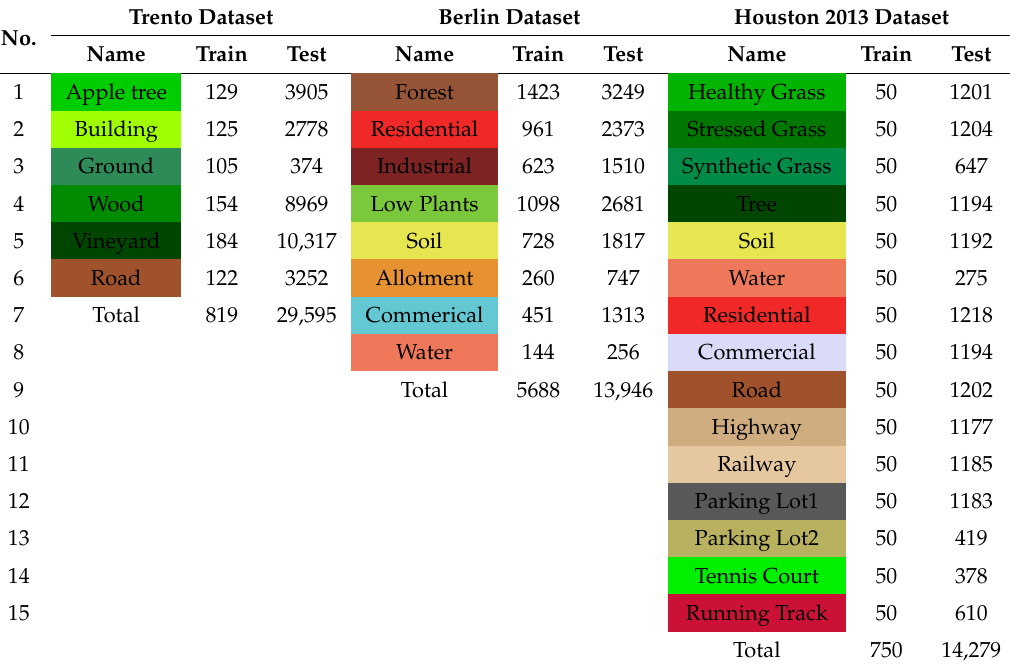
Figure 4. Houston 2013 dataset. ( a ) False color image of HSI (No. 60, 40, and 20). ( b ) LiDAR. ( c ) Groundtruth. ( d ) Class name. Table 1. Number of training and test